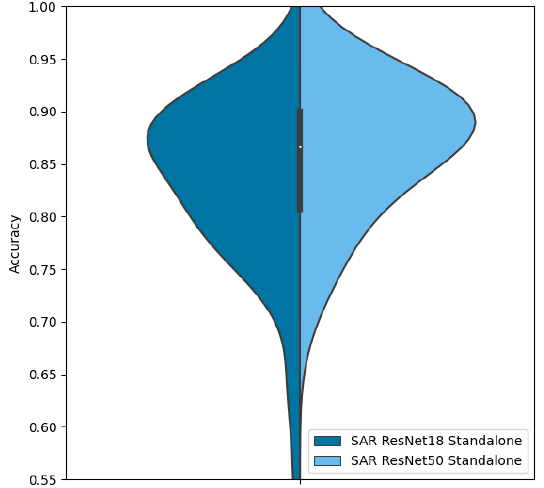
Figure 26. Accuracy distributions of ResNet18 vs. ResNet50 on SAR data.